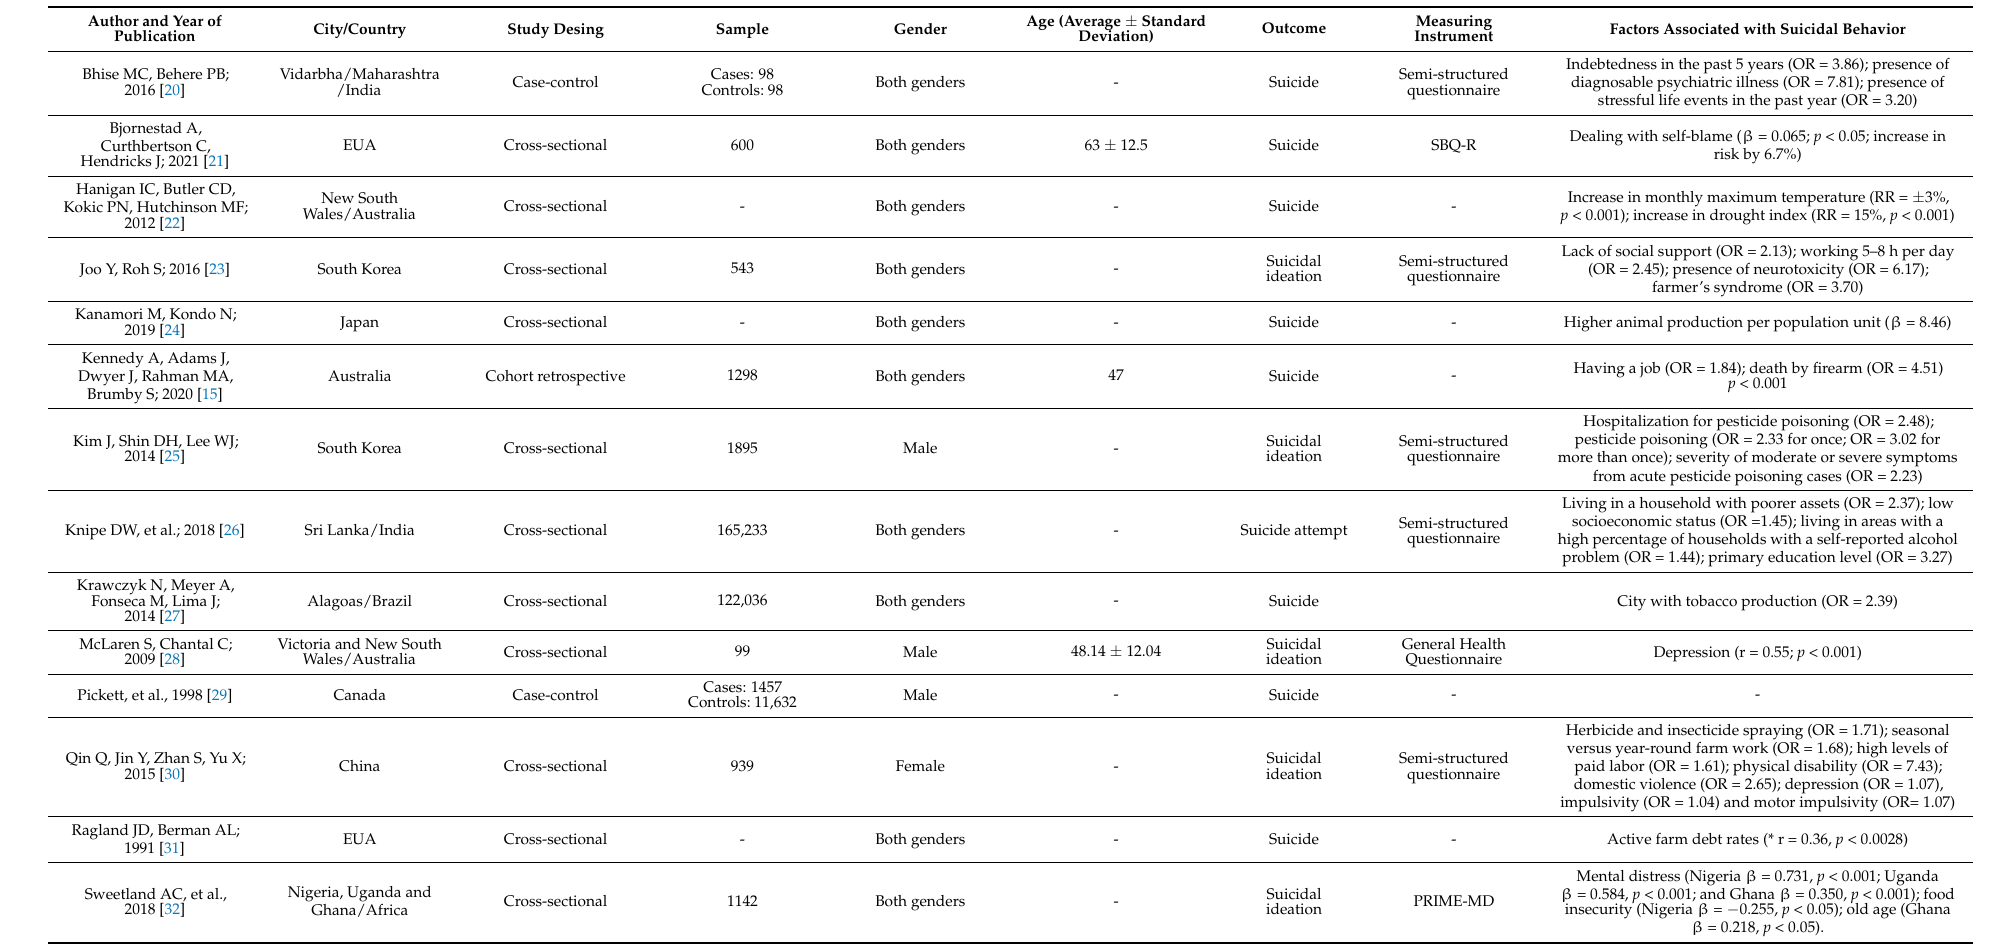
Table 1. Characteristics of included